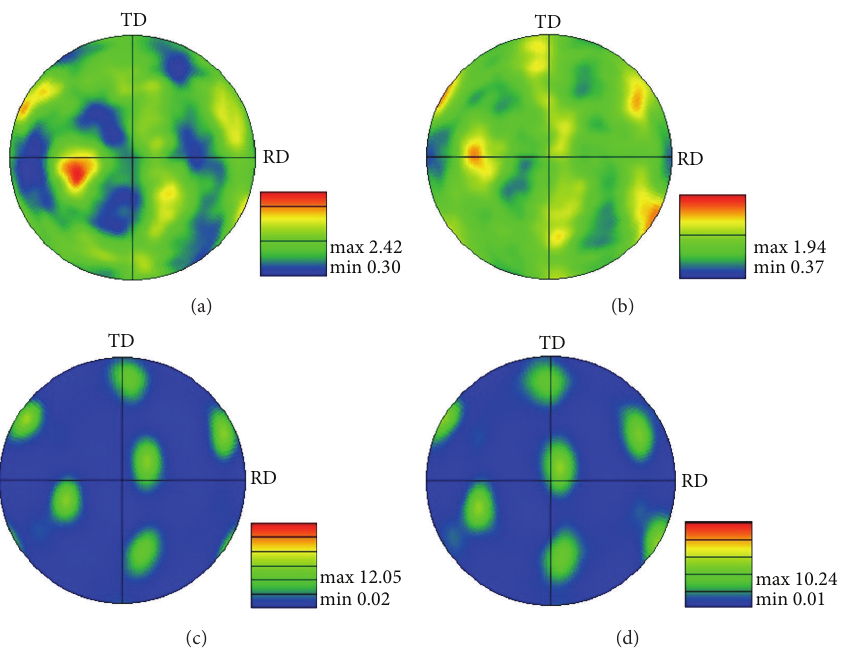
Figure 6: Pole figures of the stir zone in (a) SPCC/SPCC, (b) SPCC/SUS, (c) SUS/SPCC, and (d) SUS/SUS, respectively; RD and TD corre- spond to rolling and transversal directions, respectively.